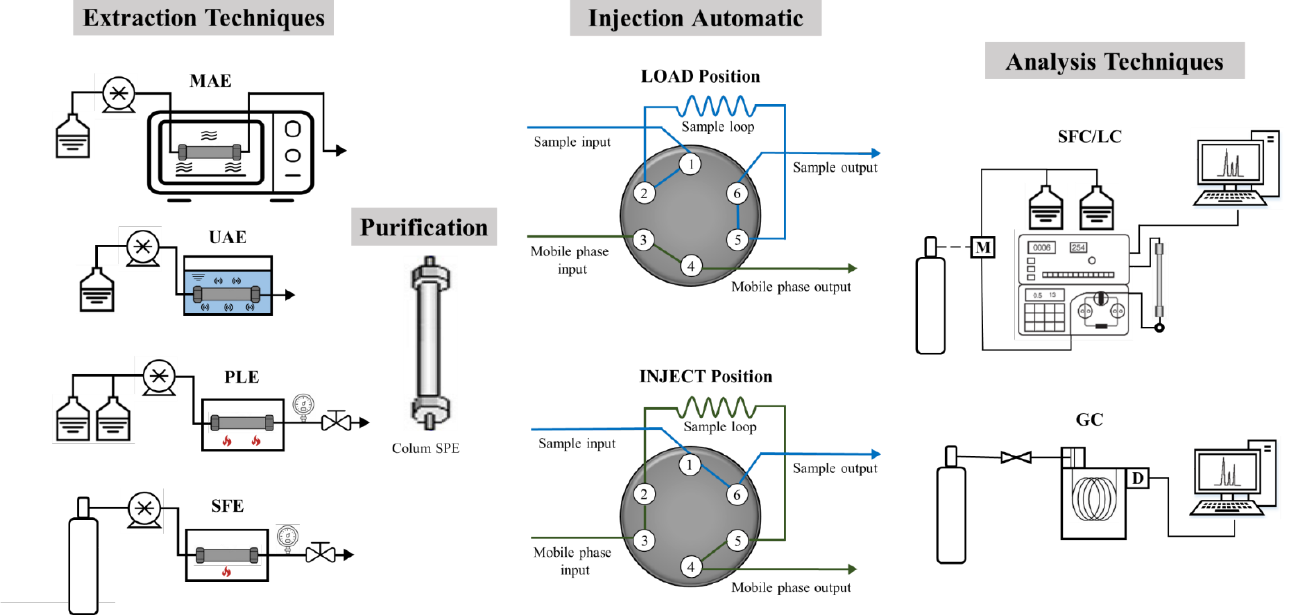
Figure 4. Simplified diagram of on-line coupling among the main extraction and analysis tech-